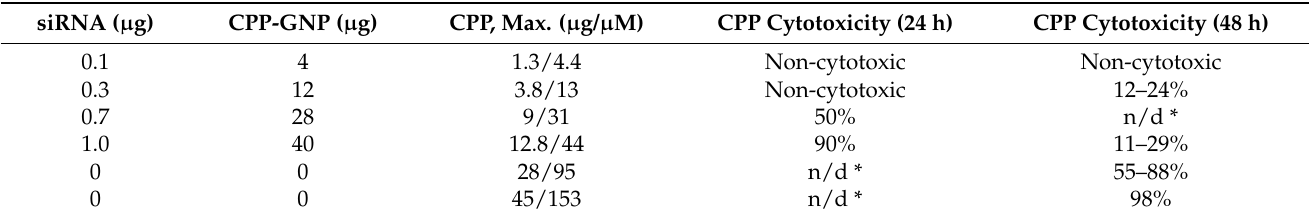
Table 1. The amounts of compounds used for transfections in a serum-free medium (Opti-MEM) and associated cytotoxicity.